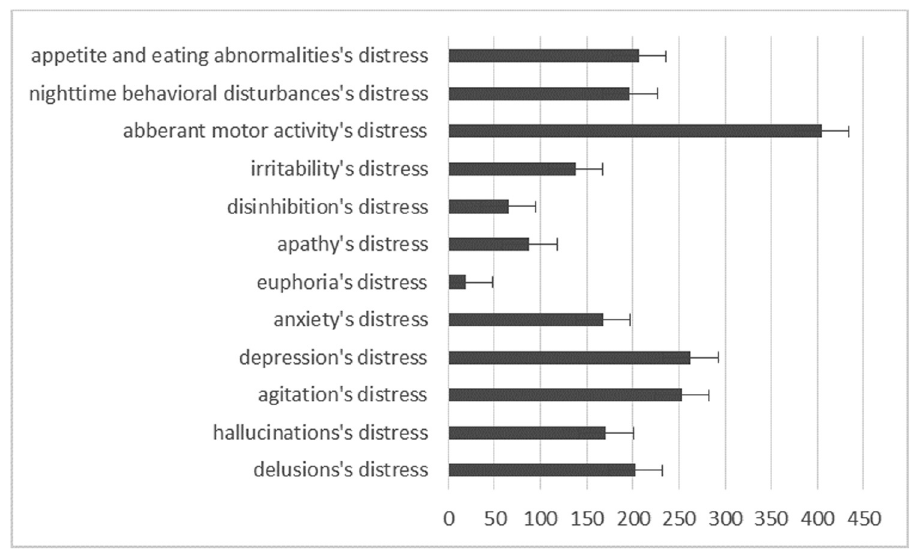
Figure 4: The caregiver ’ s distress level in the distress factor of neuropsychiatric inventory